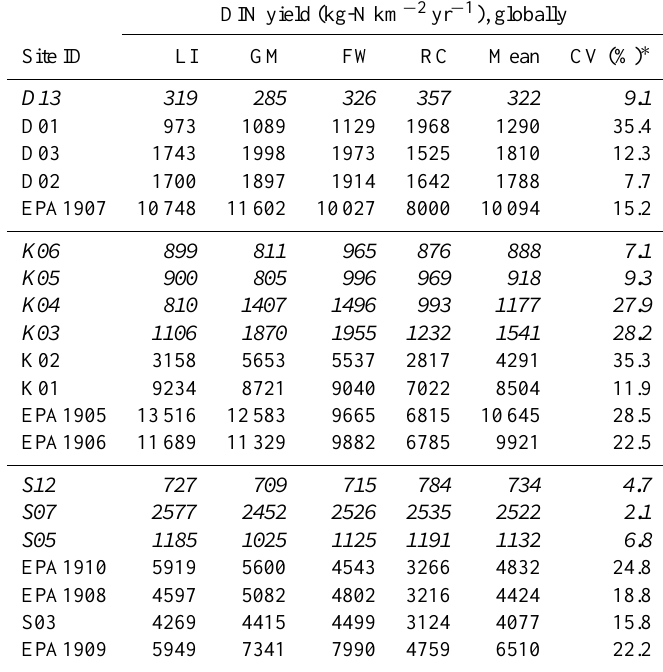
Table 4. The DIN yields at each sampling site. Four calculation methods are applied in this study. Upstream sites are coloured in